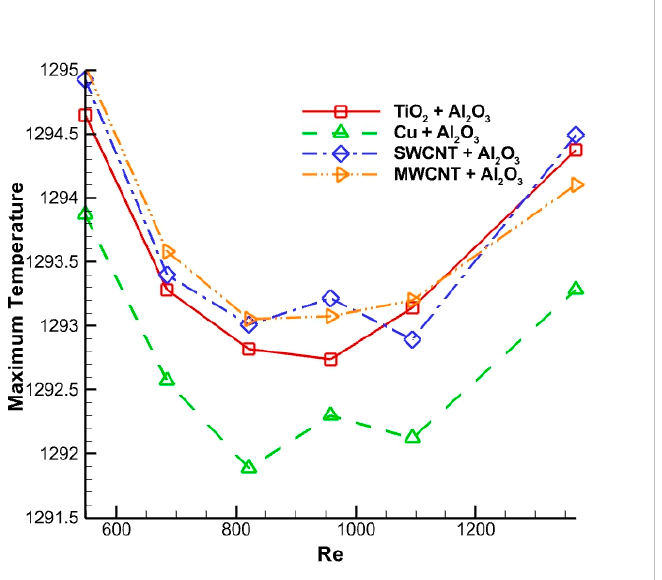
Figure 9. Variation of maximum drill bit temperature with respect to Reynolds number.